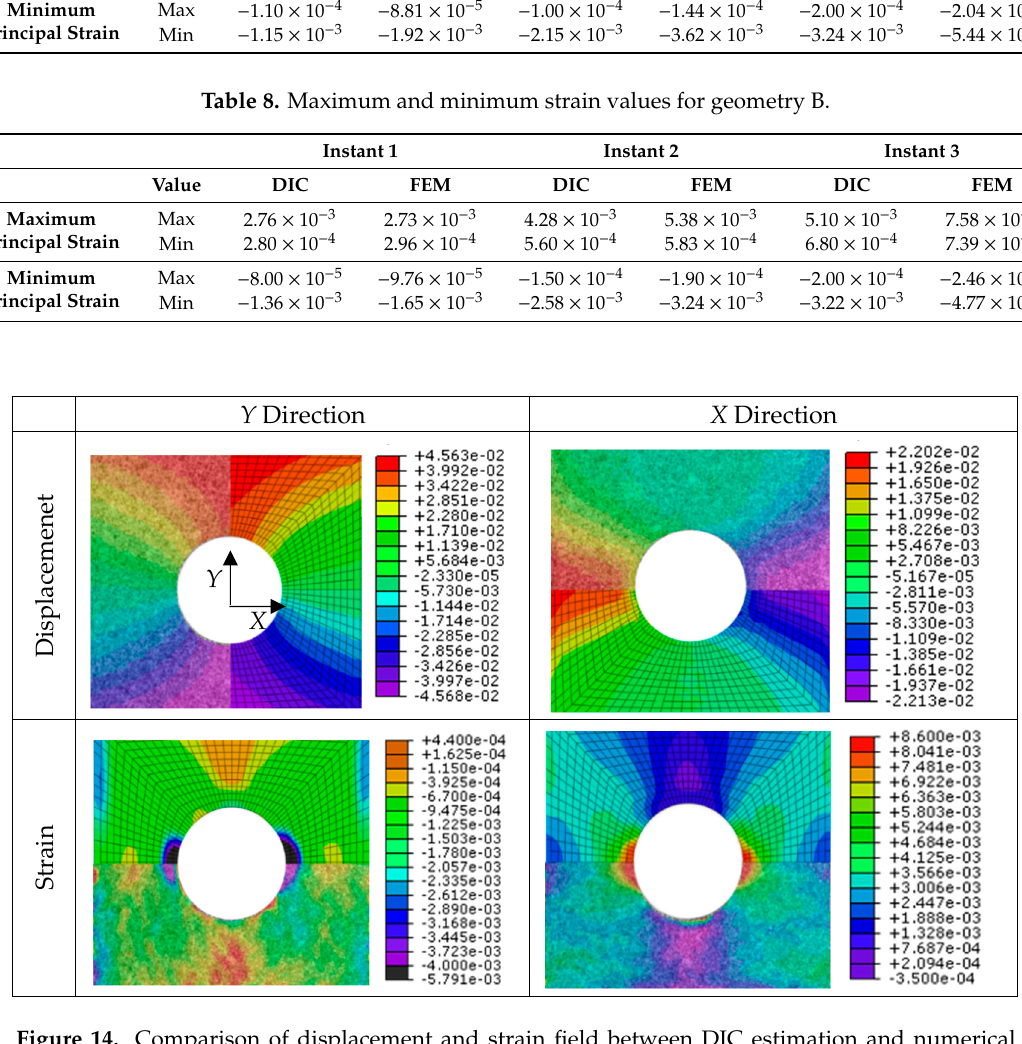
Figure 14. Comparison of displacement and strain field between DIC estimation and numerical prediction for geometry